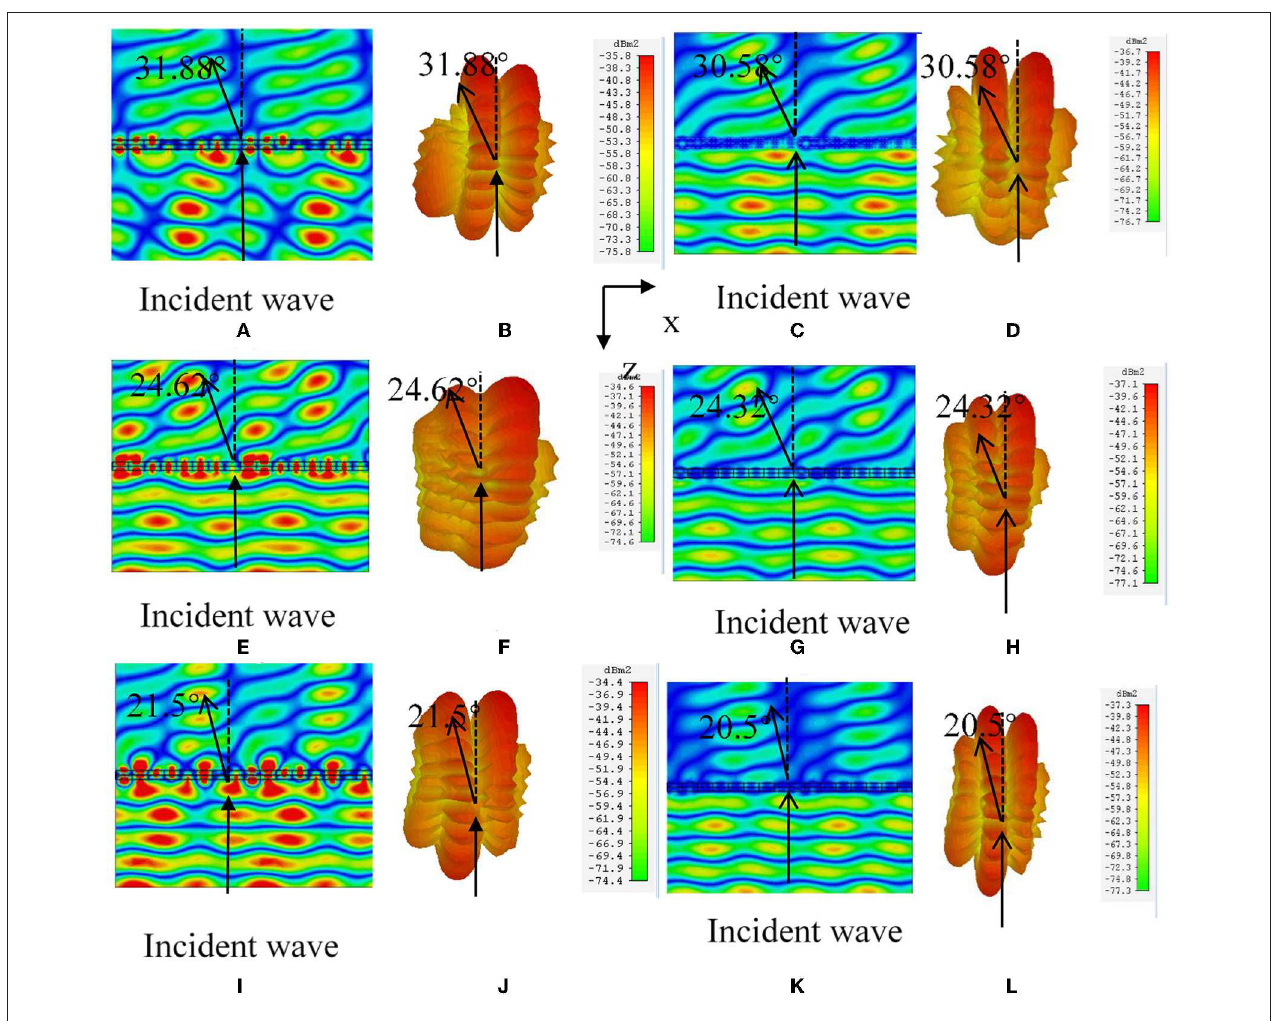
FIGURE 6 | Electric field and far-field 3D distribution of hypersurface array at 32 GHz (A–D) , 30 GHz (E–H) , and 34 GHz (I–L) of eight-element, respectively, where (A,B,E,F,I,J) indicate the results of lossless material, and (C,D,G,H,K,L) indicate the results of lossy material.